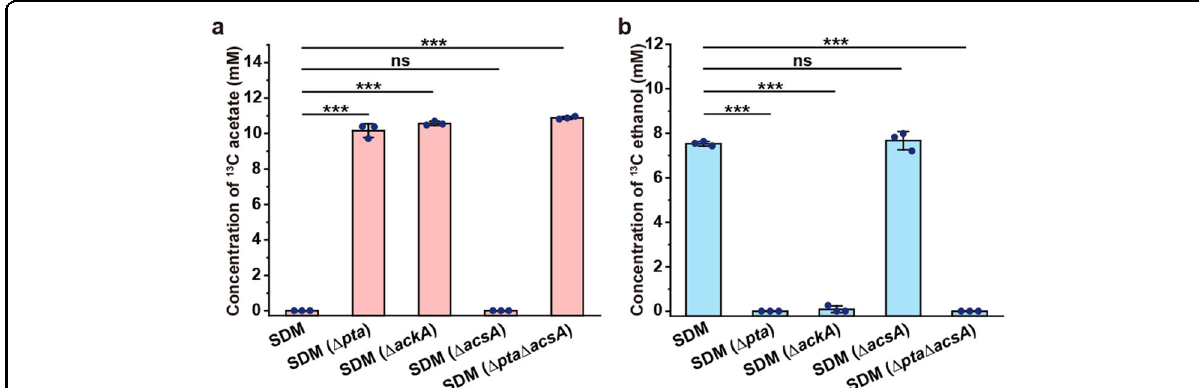
Fig. 4 Pta-AckA rather than AcsA is essential in the biotransformation of acetate to acetyl-CoA during acetate elimination. a Concentrations of 13 C-labeled acetate in E. cloacae SDM and its derivatives. b Concentrations of 13 C-labeled ethanol in E. cloacae SDM and its derivatives. 13 C sodium acetate at a concentration of about 10 mM was added into the culture system of strains at 2 h. After 4 h of culture, the concentrations of 13 C ethanol and 13 C acetate were assayed. Experiments were carried out under aerobic conditions. Data shown are means ± SD ( n = 3 independent experiments). *** P < 0.001 in two-tailed Student ’ s t -test; ns, no signi fi cant difference ( P ≥ 0.05 in two-tailed Student ’ s t